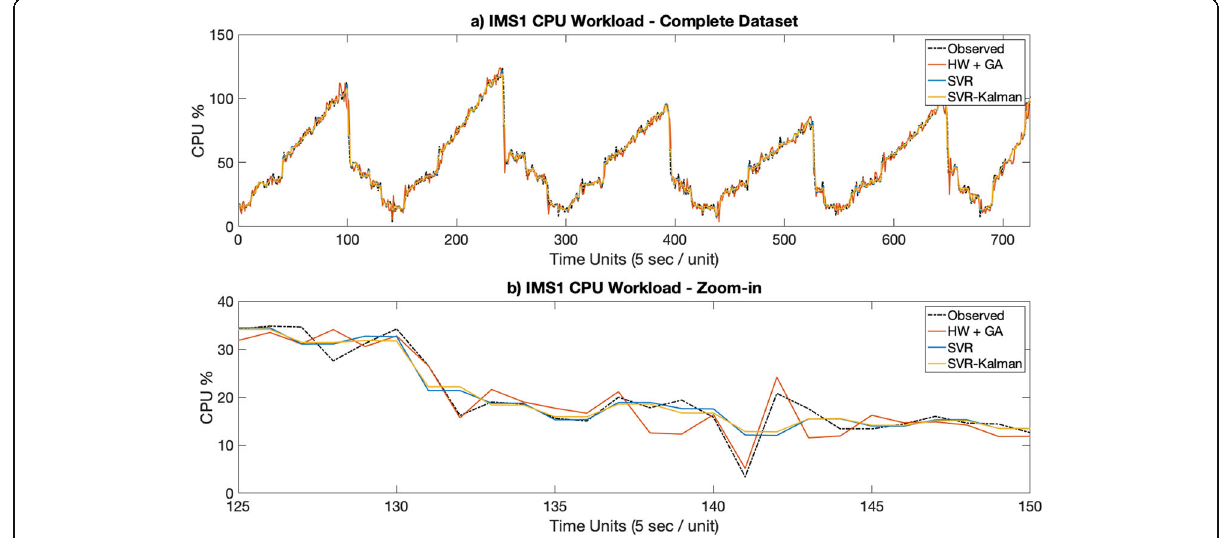
Fig. 3 IMS1 Observed and Estimated data: a Complete dataset, b